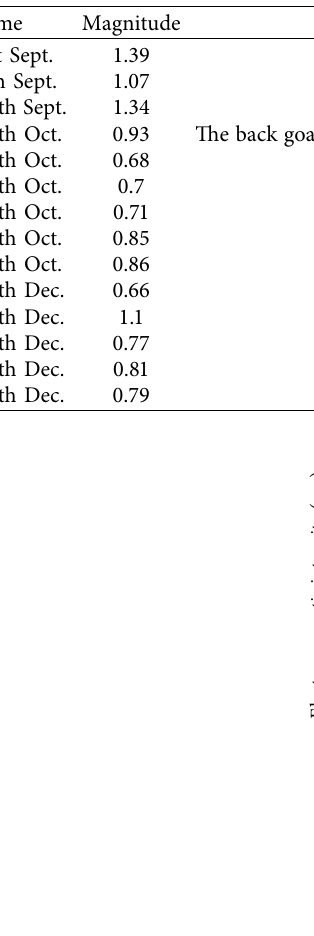
Table 2: Microseismic occurrence.